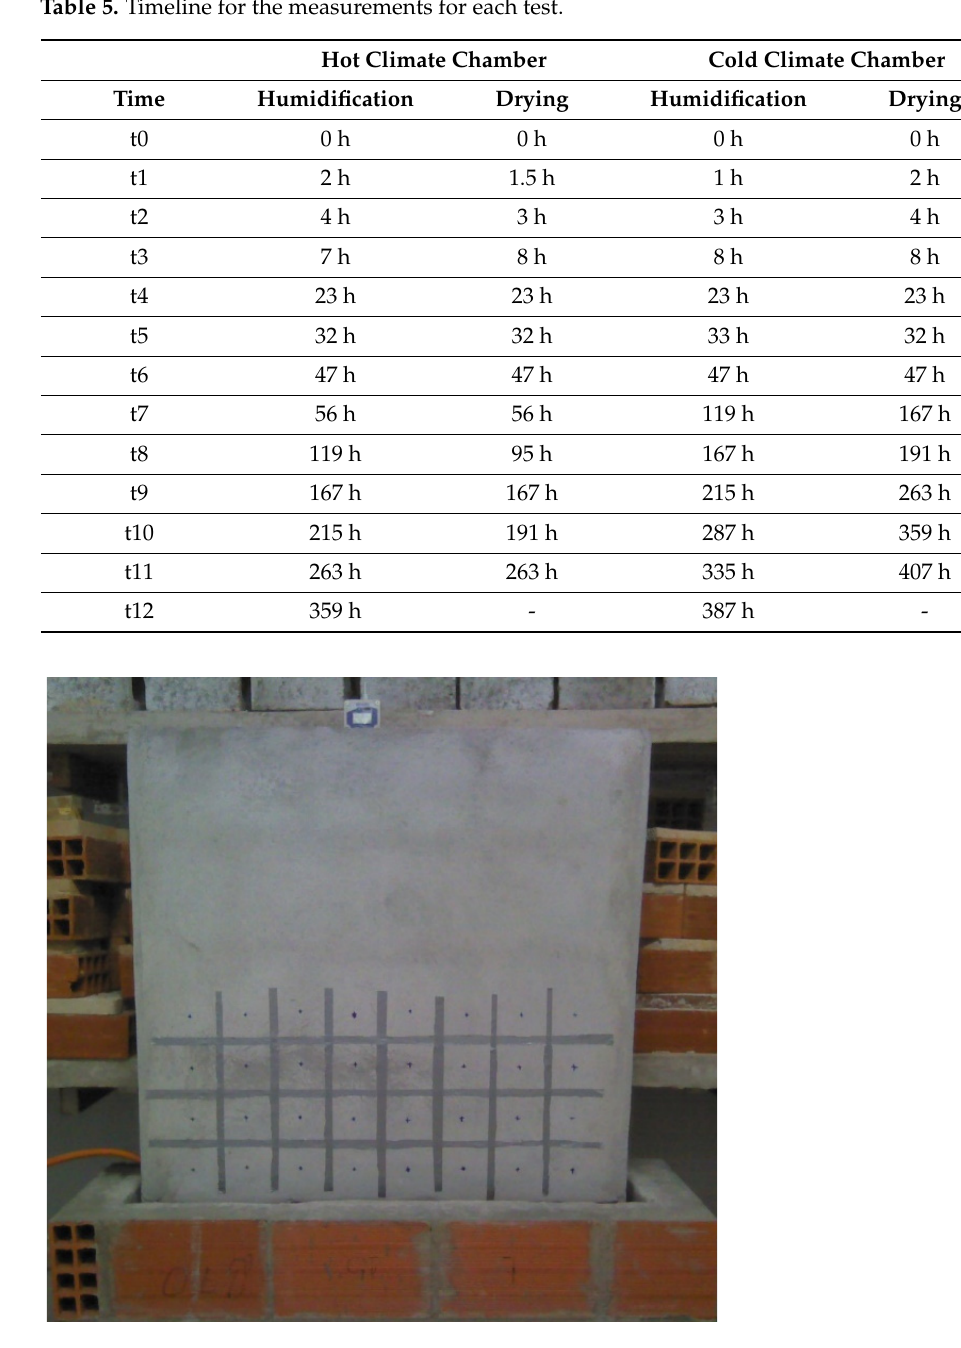
Figure 3. Areas limited on the surface of the wall to assess moisture during the humidification and the drying phases.